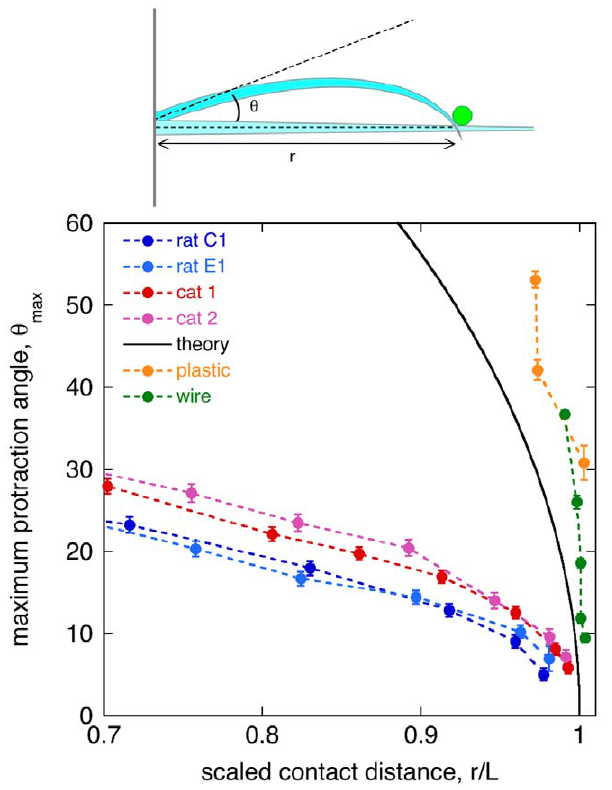
Figure 3. Maximal whisker protraction. Top: sketch of an active whisker (blue) undergoing protraction at its base during sustained contact with a stationary object (green). The protraction angle h is defined relative to the surface normal. Bottom: re-display of the data shown in Fig. 1, to show the maximum protraction angle as a function of normalized object distance r/L . Symbols as in Fig. 2.